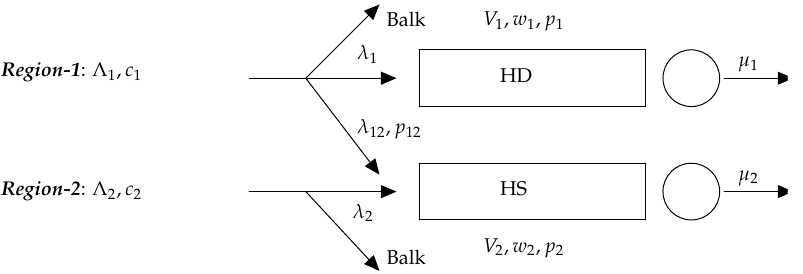
Figure 1. Graphic representation of the system